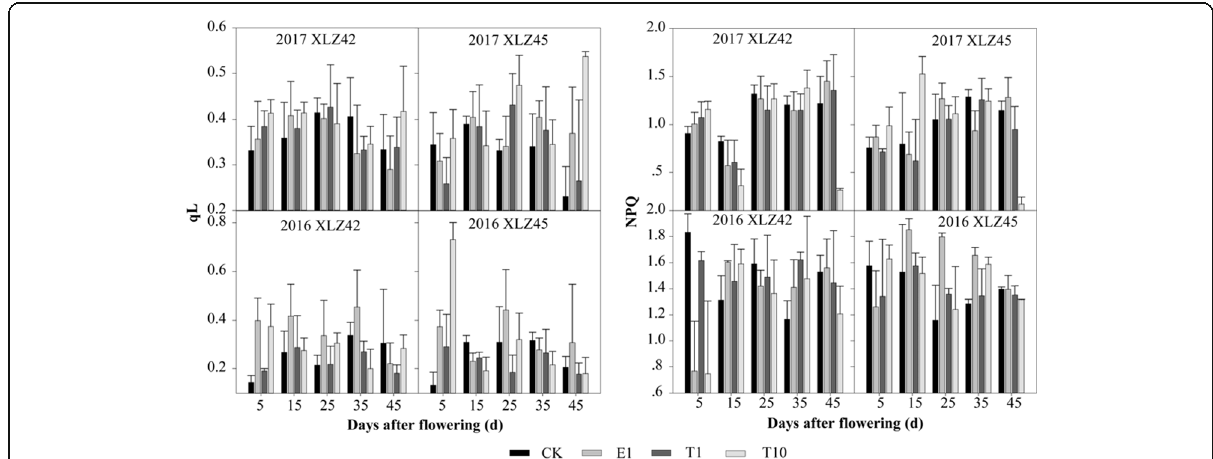
Fig. 6 Coefficient of photochemical fluorescence quenching assuming an interconnected PS-II antennae (qL) and Stern-Volmer type non- photochemical fluorescence quenching (NPQ) of cotton varieties (XLZ42 and XLZ45), at different days since flowering in various treatment groups: 1 and 10 days before the first irrigation (T1, T10, respectively) and 1 day before the second irrigation (E1) after seedling emergence, during 2016 – 2017. The control group (CK) had film mulching throughout the growth stages. Bars are means ± standard deviation (n =